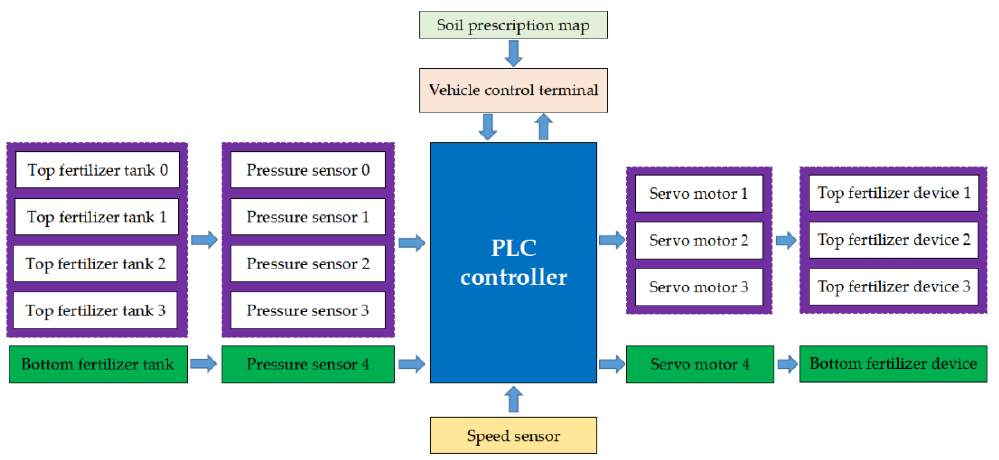
Figure 2. Overall design structure diagram of variable formula fertilizer control